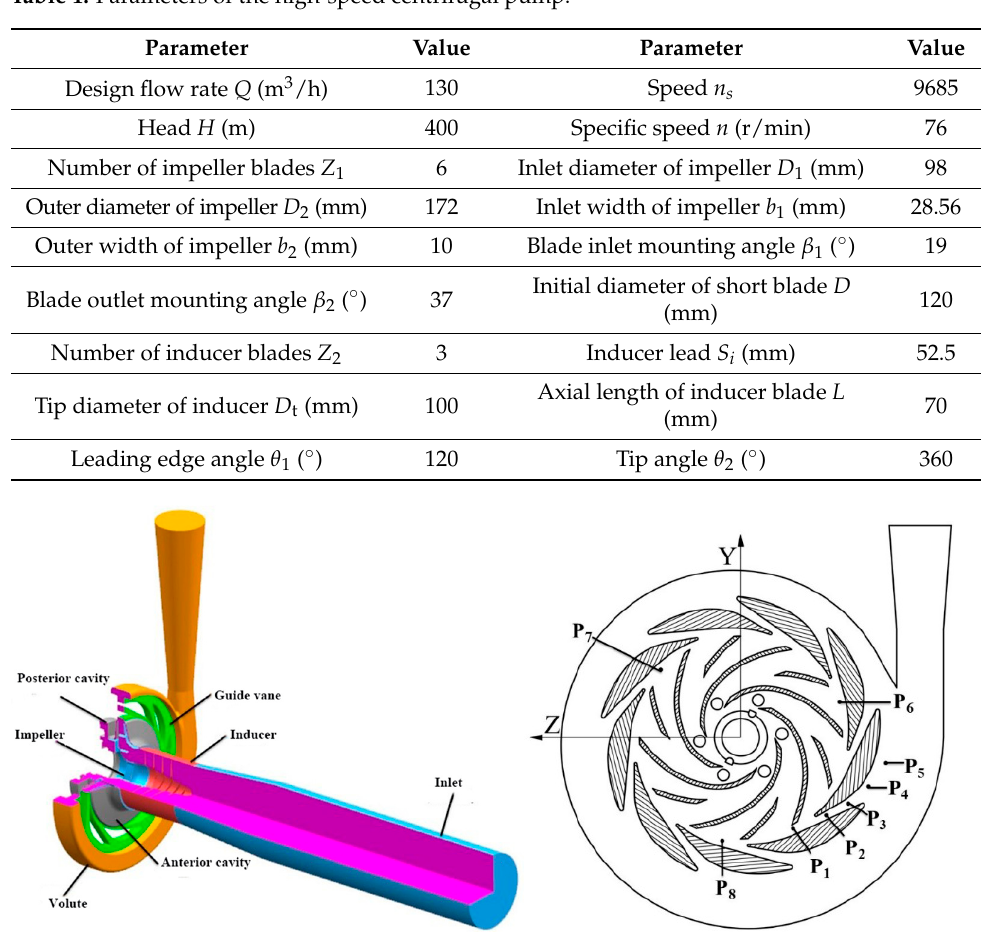
Figure 5. Pump model and detection points.